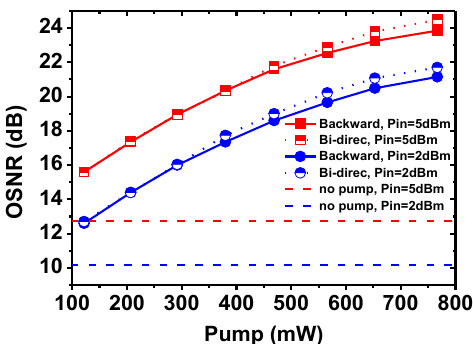
Figure 2. OSNR versus Raman pump power for two pumping schemes, backward pumping only with 95% and backward pumping with 95% together with co-pumping with 5% for two different launching powers.